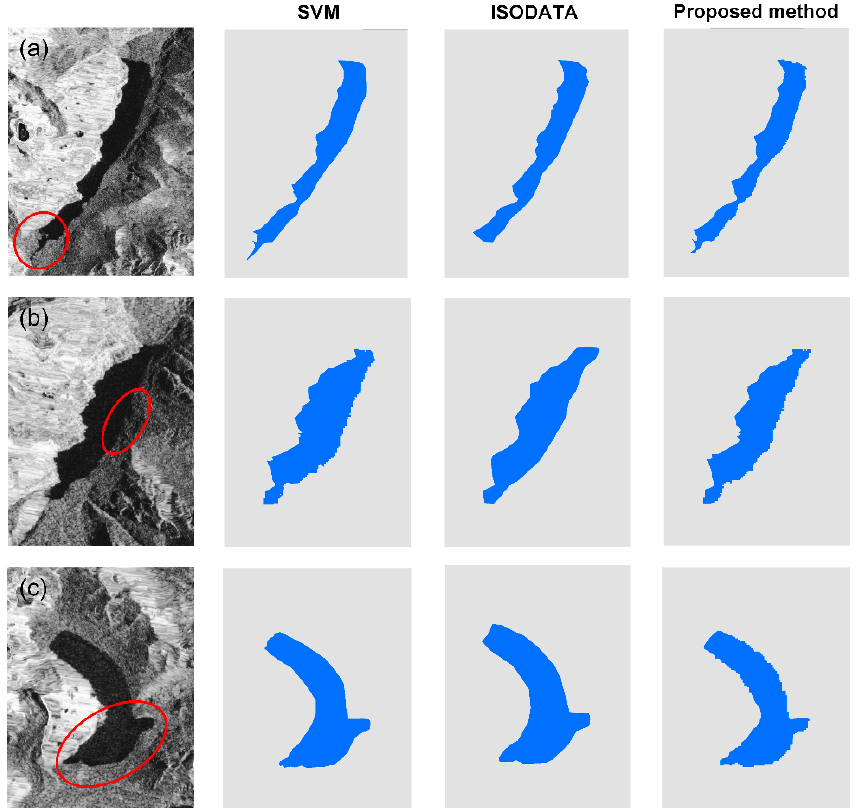
Figure 5. Comparison of the glacial lake extent extracted from Sentinel-1A/1B data in 2018 using SVM, ISODATA, and the proposed method for three sampled glacial lakes at: ( a ) 94.25°E, 30.05°N; ( b ) 93.64°E, 30.24°N; and ( c ) 94.28°E, 29.91°N.